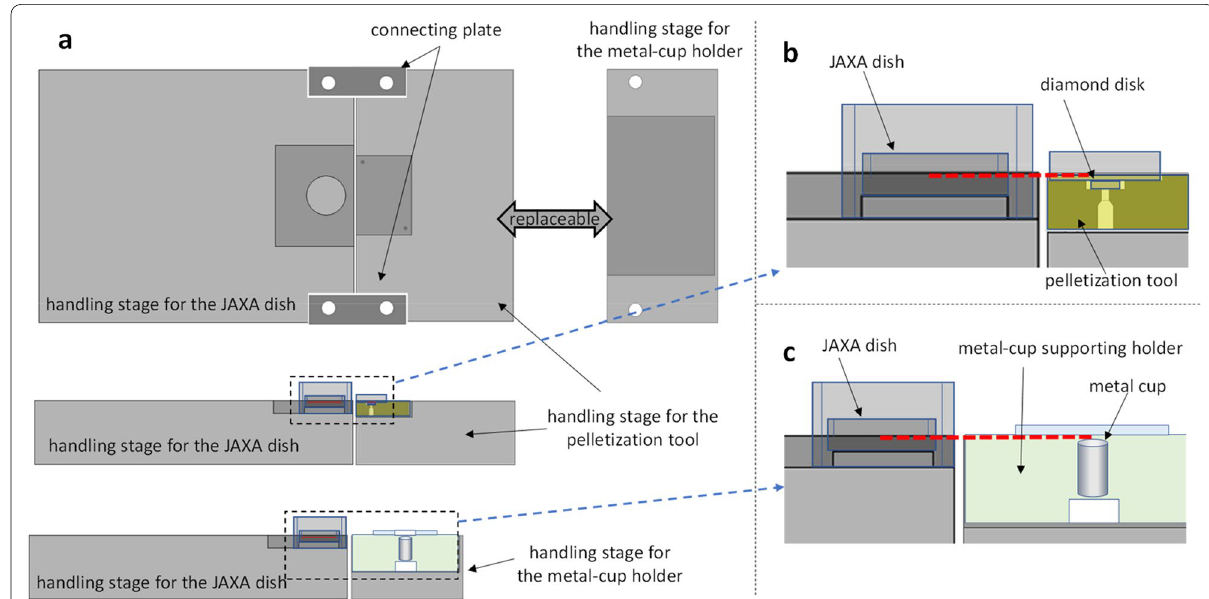
Fig. 2 Handling stage used for sample collection from the sapphire dishes distributed from JAXA. a . The left block was used to set the JAXA dishes, whereas the right block is replaceable for the pelletization or encapsulation. b . Enlarged view of the cross-section of the setting for the pelletization. A dotted red line shows the height of the samples in the JAXA dish and that of the diamond disk used for the pelletization. c . Enlarged view of the cross-section of the setting for the encapsulation. A dotted red line shows the height of the samples in the JAXA dish and that of the top of the metal